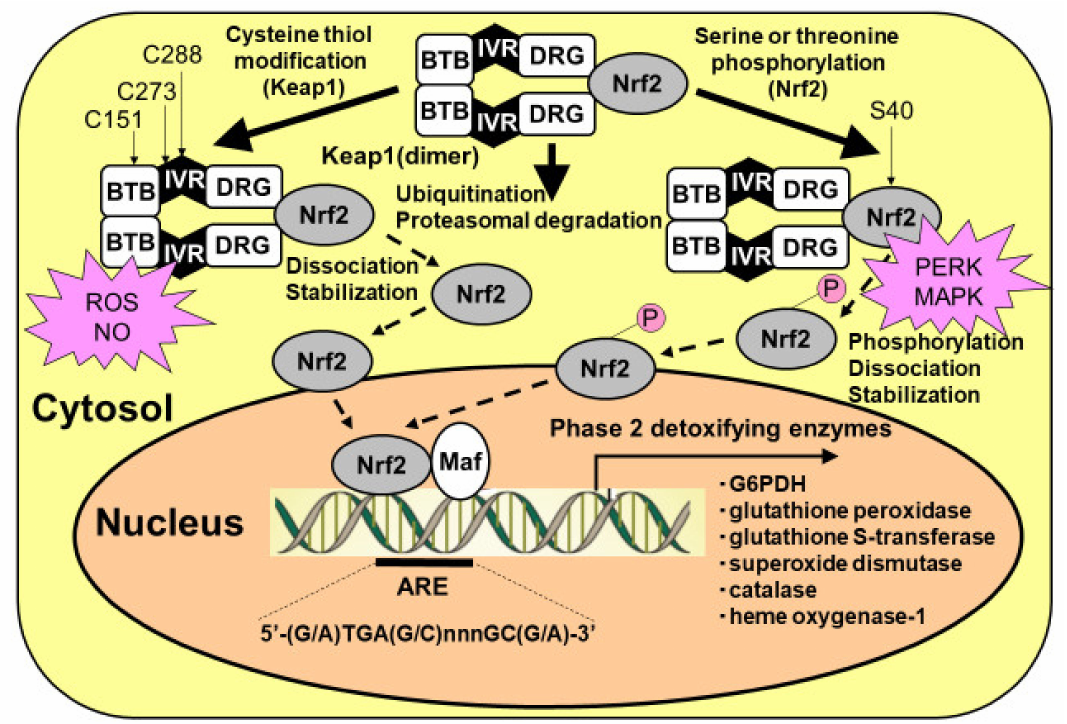
Figure 4. Activation of Kelch-like enoyl-CoA hydratase-associated protein 1 (Keap1)/nuclear factor erythroid 2 p45 subunit- related factor 2 (Nrf2) system in astrocytes. Nrf2 can be activated by at least two mechanisms: (1) the stabilization of Nrf2 via Keap1 cysteine thiol modification, and (2) the phosphorylation of serine residues of Nrf2 by upstream kinases, such as RNA (PKR)-like ER kinase (PERK) and mitogen-activated protein kinase (MAPK). Keap1 presents two characteristic domains, the bric-a-brac, tramtrack, and broad complex (BTB) domain, and the double glycine repeat (DGR) domain. Keap1 bridges the Cullin-3-based E3 ligase and Nrf2 using its BTB and the central intervening region (IVR) to bind Cullin-3 and its DGR to bind Nrf2. The BTB domain participates in Keap1 dimerization. Under basal conditions, Nrf2 is continuously degraded by the ubiquitin/proteasomal system. At least two different mechanisms that facilitate the dissociation of Nrf2 from Keap1, leading to Nrf2 translocation from the cytosol to the nucleus, are known. One involves the modification of thiol residues in the Keap1 protein by reactive oxygen species (ROSs) and nitric oxide (NO). Another mechanism for the dissociation of the Keap1/Nrf2 complex is the phosphorylation of serine residues of Nrf2. Nrf2 then translocates to the nucleus and must heterodimerize with members of the Maf proto-oncogene family to bind to regulatory elements in the DNA and increase antioxidant response element (ARE)-driven